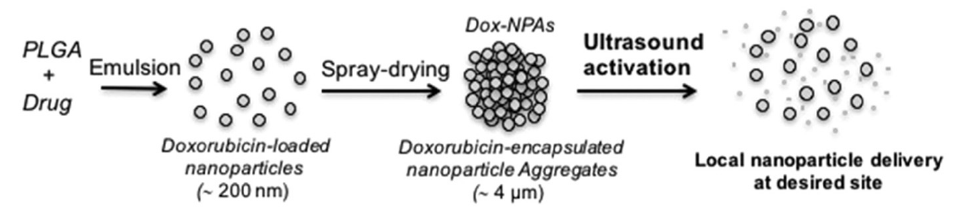
Figure 11. A schematic representation of PLGA carriers with ultrasound release. [28] Reprinted from Biomaterials, 139, A-L. Papa et al., Ultrasound-Sensitive Nanoparticle Aggregates for Targeted Drug Delivery, 187–194, Copyright (2017), with permission from Elsevier.